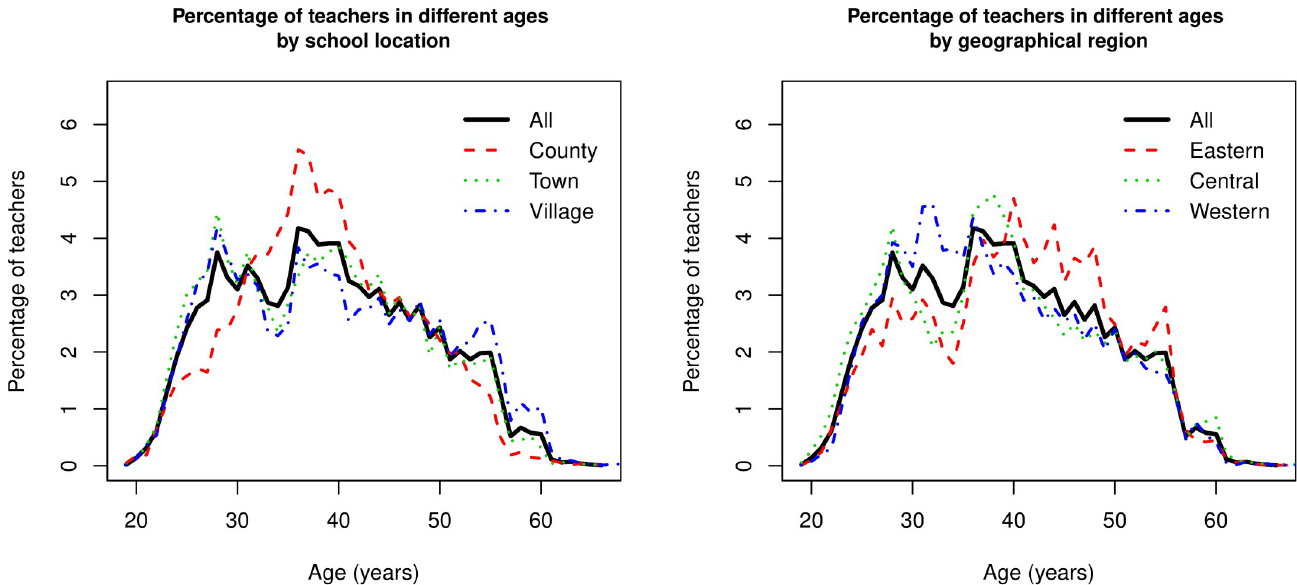
Fig 1. Percentage of teachers in terms of age by school location and geographical region.